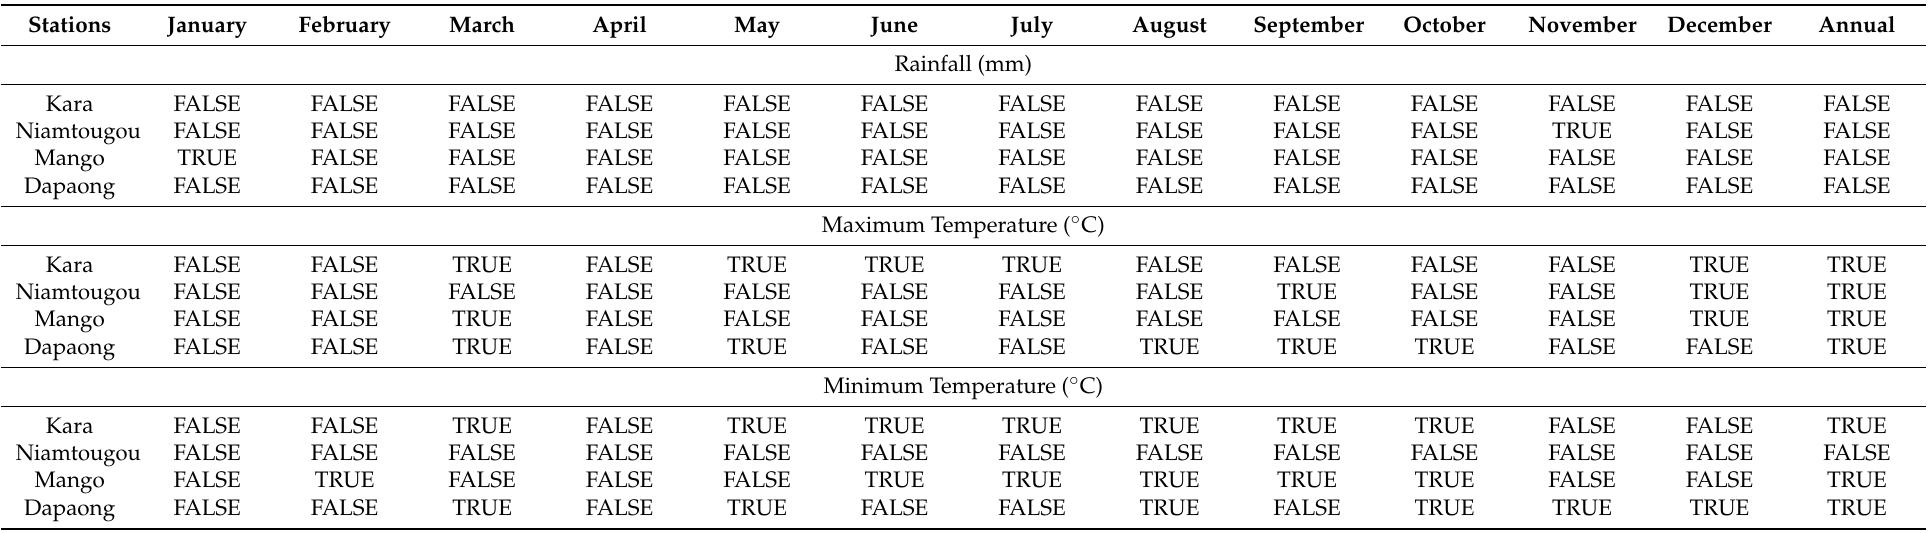
Table 4. Summary of serial correlation results of the rainfall (mm) and temperature data ( ◦